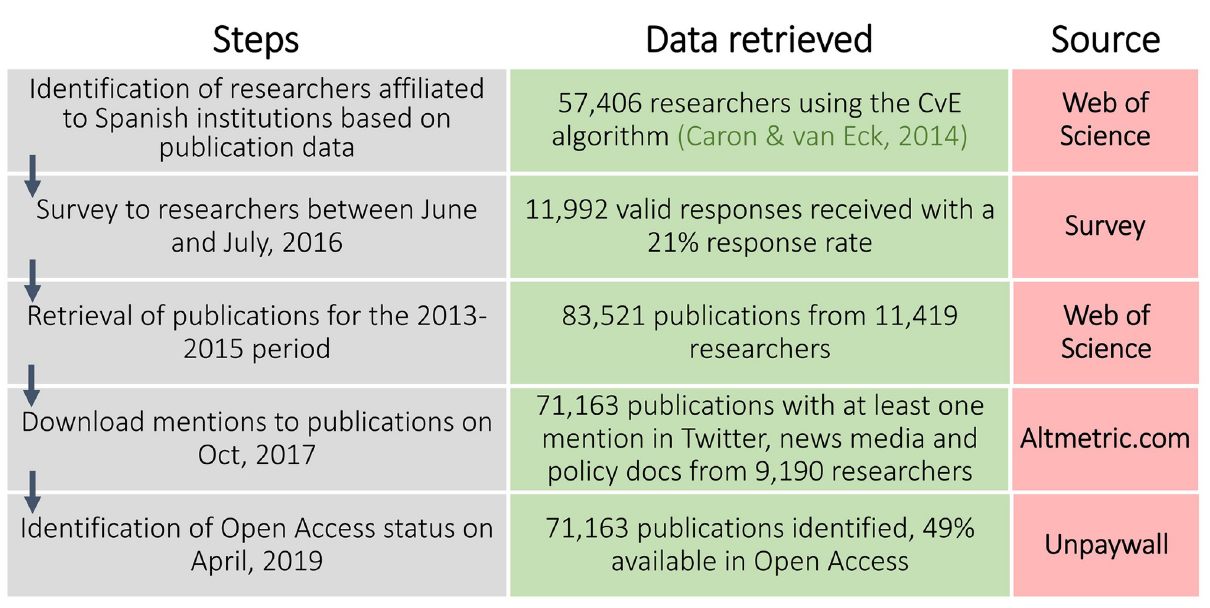
Fig 1. Overview of the data retrieval steps, number of records and data source used.